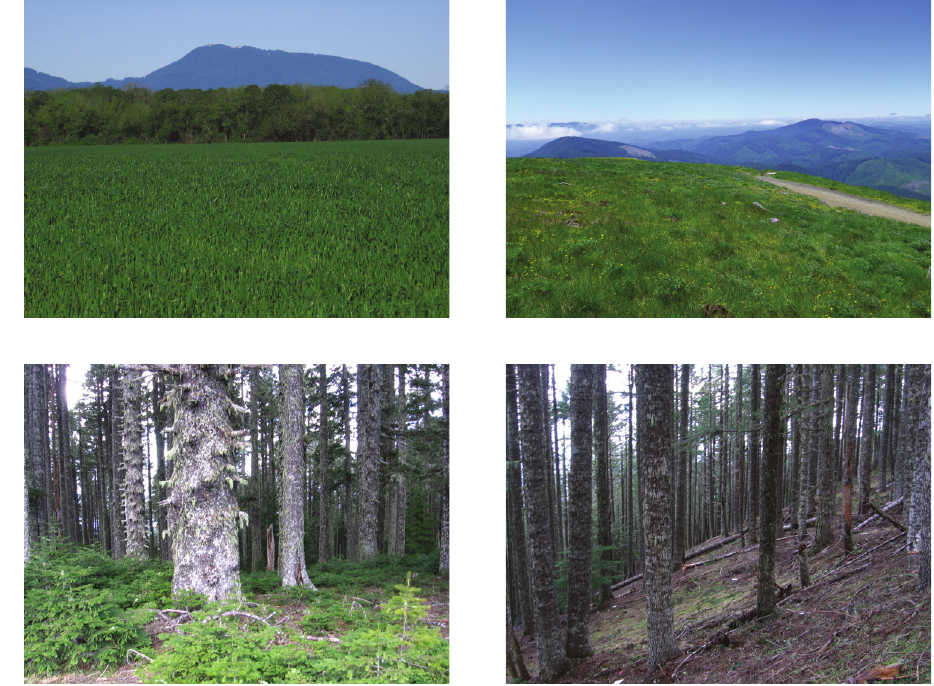
Figures 11–14. Oregon Coast Range, Marys Peak 11 (upper left), Marys Peak in May, seen from the Willamette Valley south of Corvallis 12 (upper right), meadow at summit (courtesy D.R. Maddison) 13 (lower left), old growth noble fir stand on north flank 14 (lower right), old growth noble fir stand on northwest